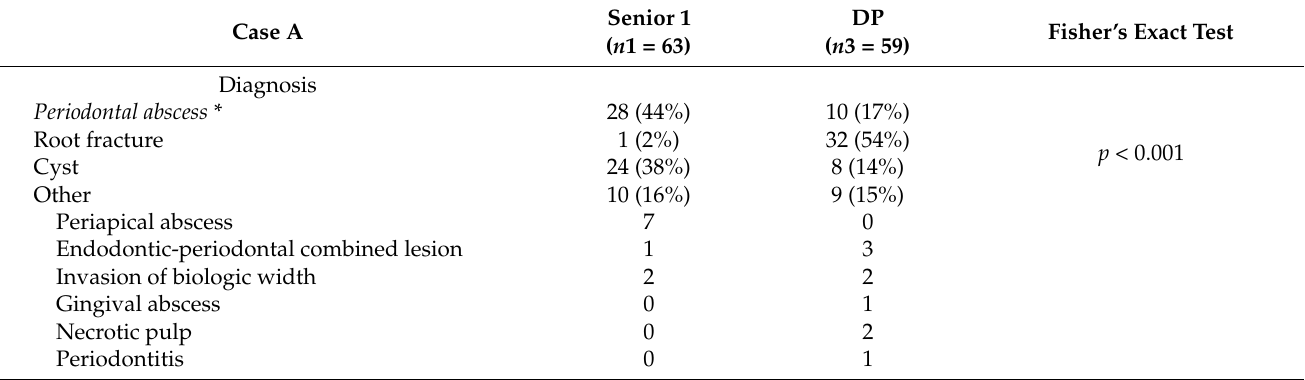
Table 3. Distribution of the responses to items from the senior 1, senior 2, and dental practitioner (DP)